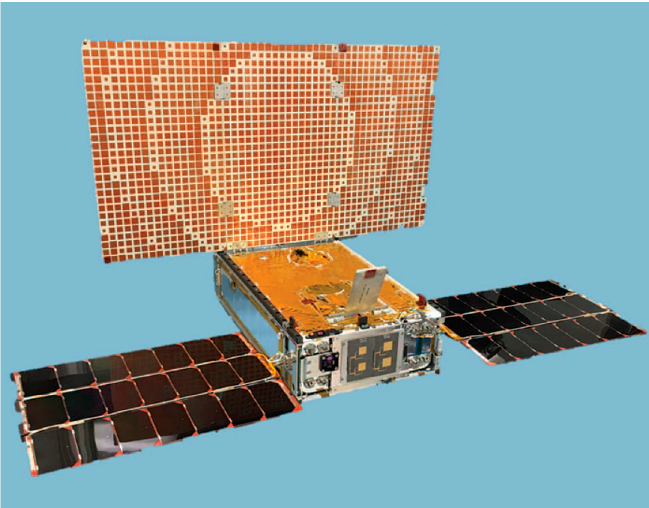
Figure 6. MarCO LGAs and MGAs (Courtesy of N. Chahat).